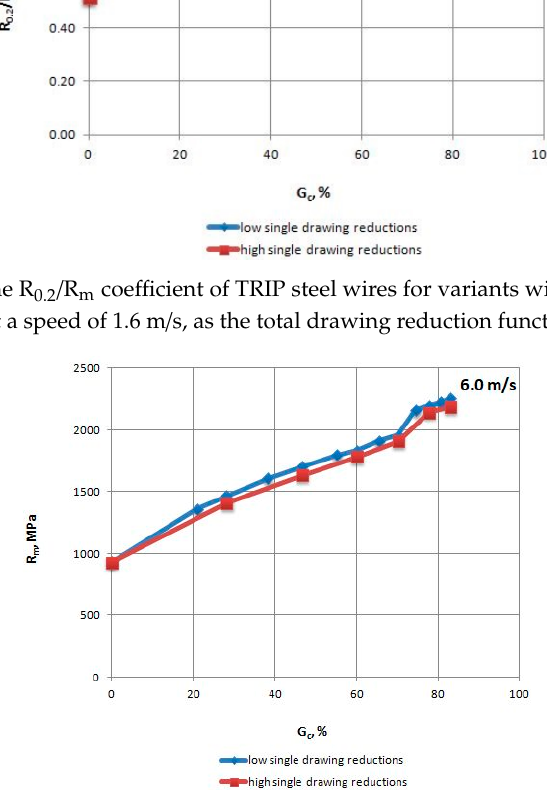
Figure 5. Change in the tensile strength Rm of TRIP steel wires for variants with low and high single drawing reductions, at a speed of 6.0 m/s, as the total drawing reduction function.